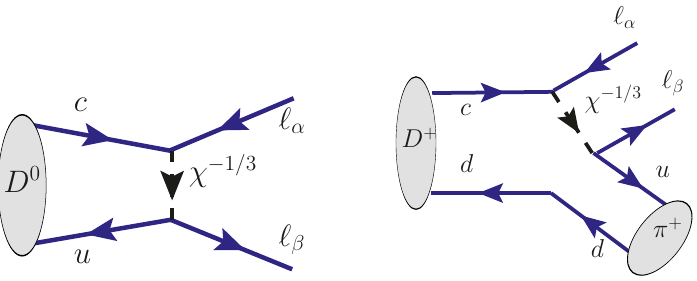
Figure 27 . Feynman diagram for rare leptonic and semileptonic D -meson decays mediate by the (cid:31)